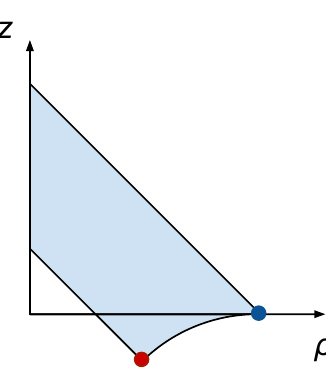
Figure 2 . A hypothetical case of an orbit space lacking convexity in its charge-breaking